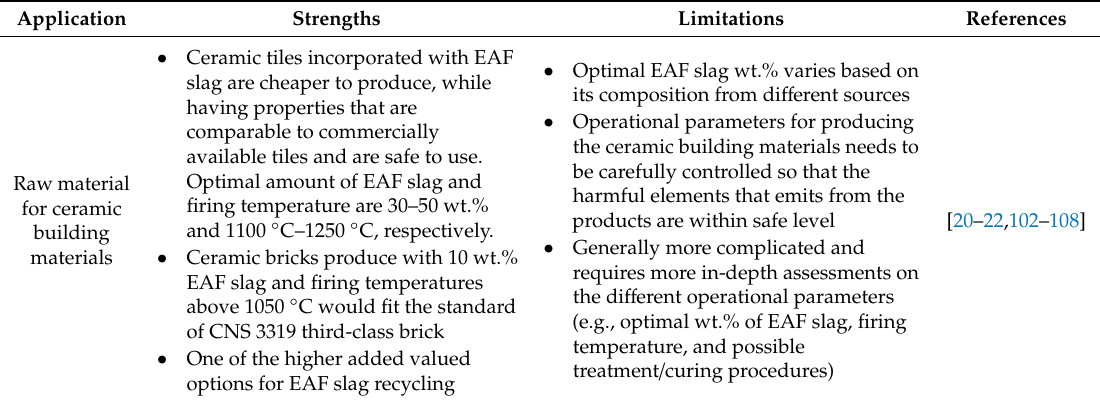
Table 9. Strengths and limitations of incorporating EAF slag in raw material for ceramic building